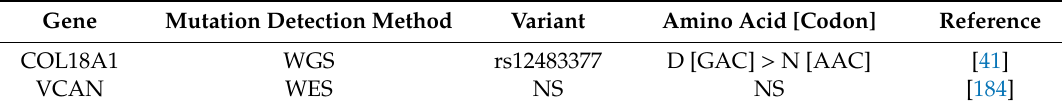
Table 4. Identified BM gene mutations in IPAH